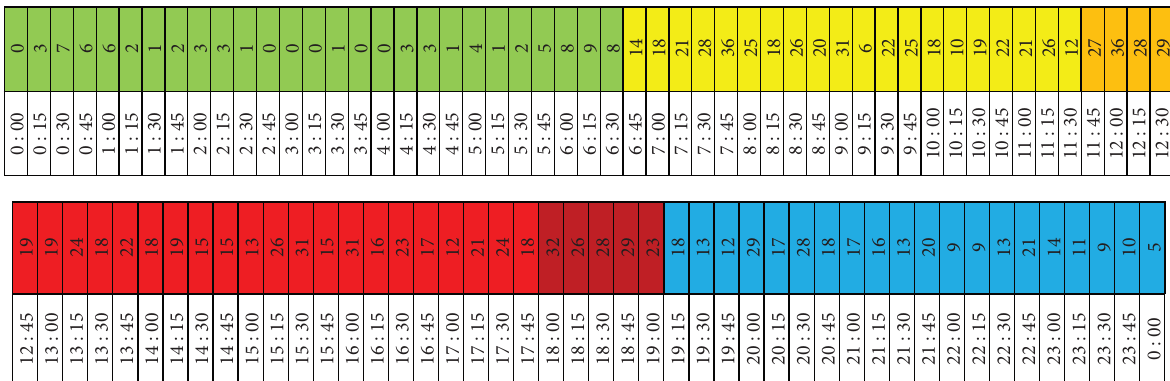
Figure 2: Time segment division results of trafc-fow sequence using the dynamic Fisher clustering algorithm.